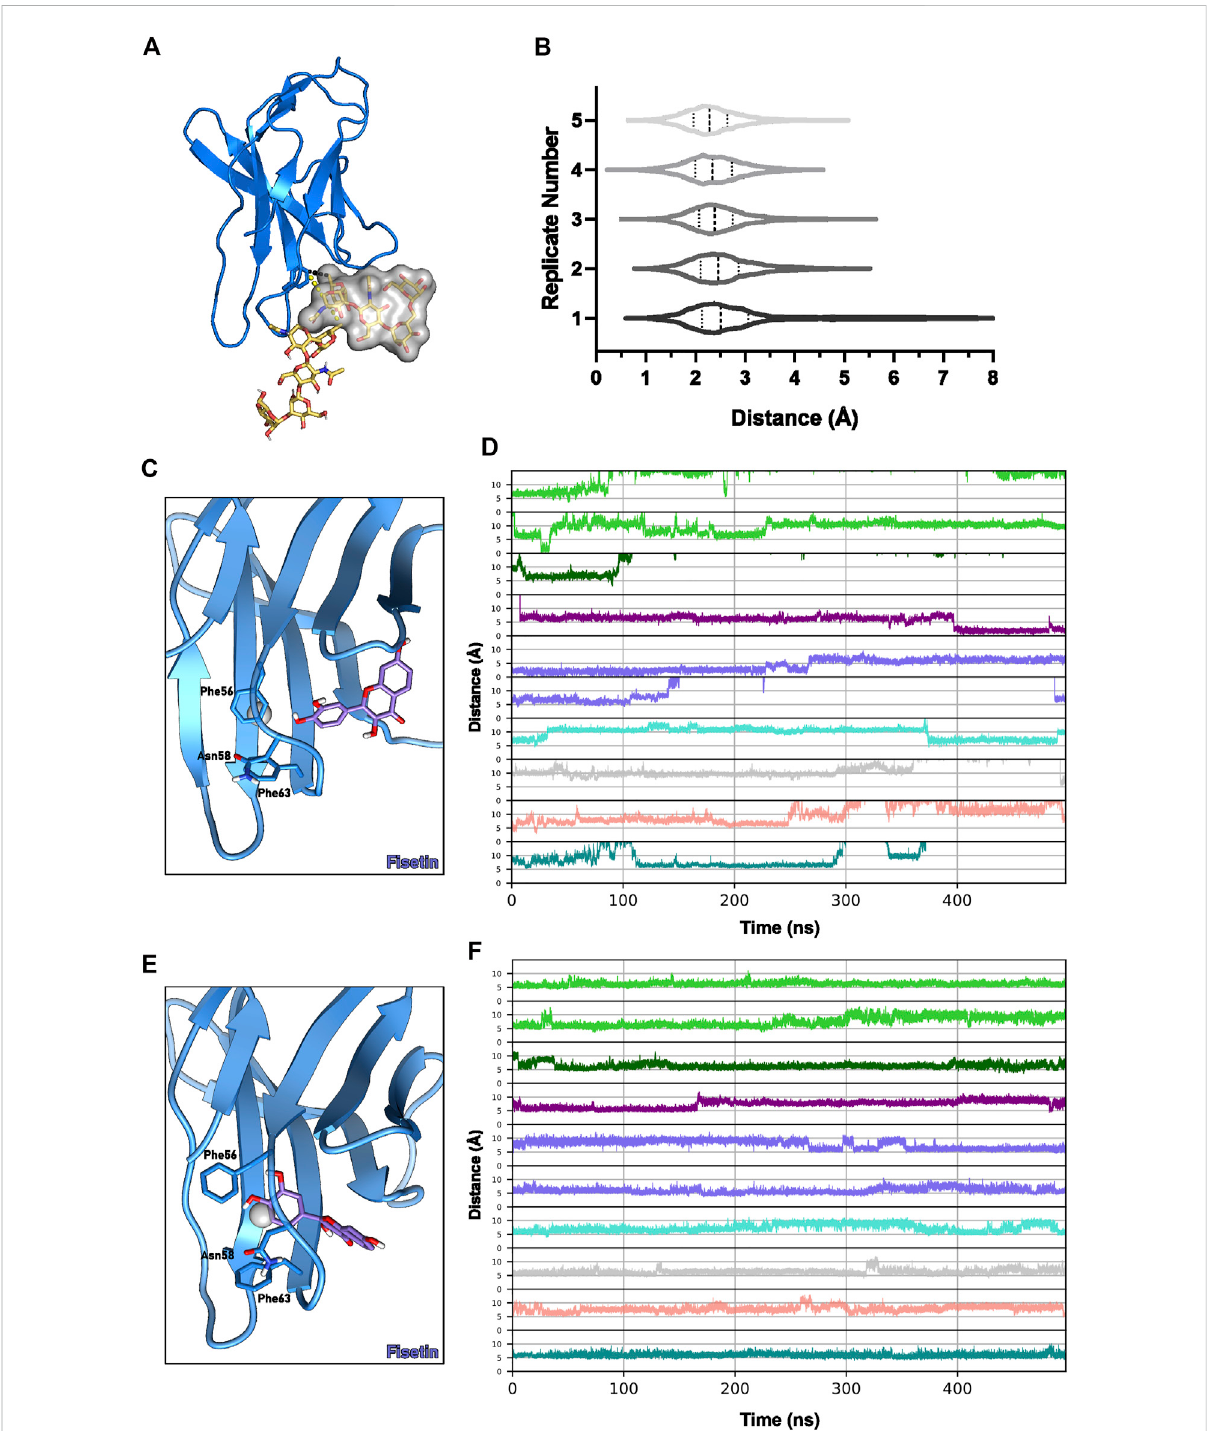
FIGURE 5 C3 PD − 1 cavity dynamics. (A) Conformations of the glycoside attached to Asn58 before (yellow sticks and surface) and after (yellow sticks) a MD simulation of Asn58-glycosilated PD-1 (cartoon, blue). (B) Distances between C ζ -Phe63 and the glycan in fi ve MD replicates. Example of a fl avonoid pose (C) outside and (E) insidethepocket formedbythePhe56/Phe63dihedral fl ipintheBCloop.Bluesticksrepresent the fi setin molecule, andthe pocket centroid is a gray sphere. (D) Molecules ’ distance to the centroid of the pocket de fi ned between the C α -Phe56 and C α -Phe63 throughout500-nssimulations. (F) DistancesbetweentheC α -Phe56andC α -Phe63duringthe500-nssimulations.Plotlinesarecoloredaccording to themolecule complexedwith PD-1: apigenin,green;cosmosiin, dark green; eriodictyol,purple; fi setin, blue;kaempferol,cyan; kaempferol-7-O- rhamnoside, gray; luteolin, salmon; quercetin,